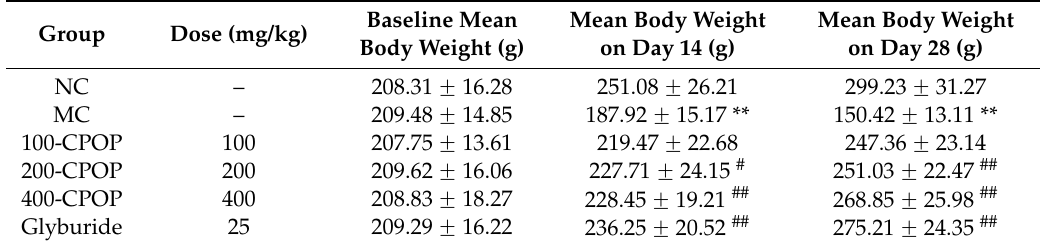
Table 1. Mean body weight of rats by study group ( x ˘ SD, N = 8).